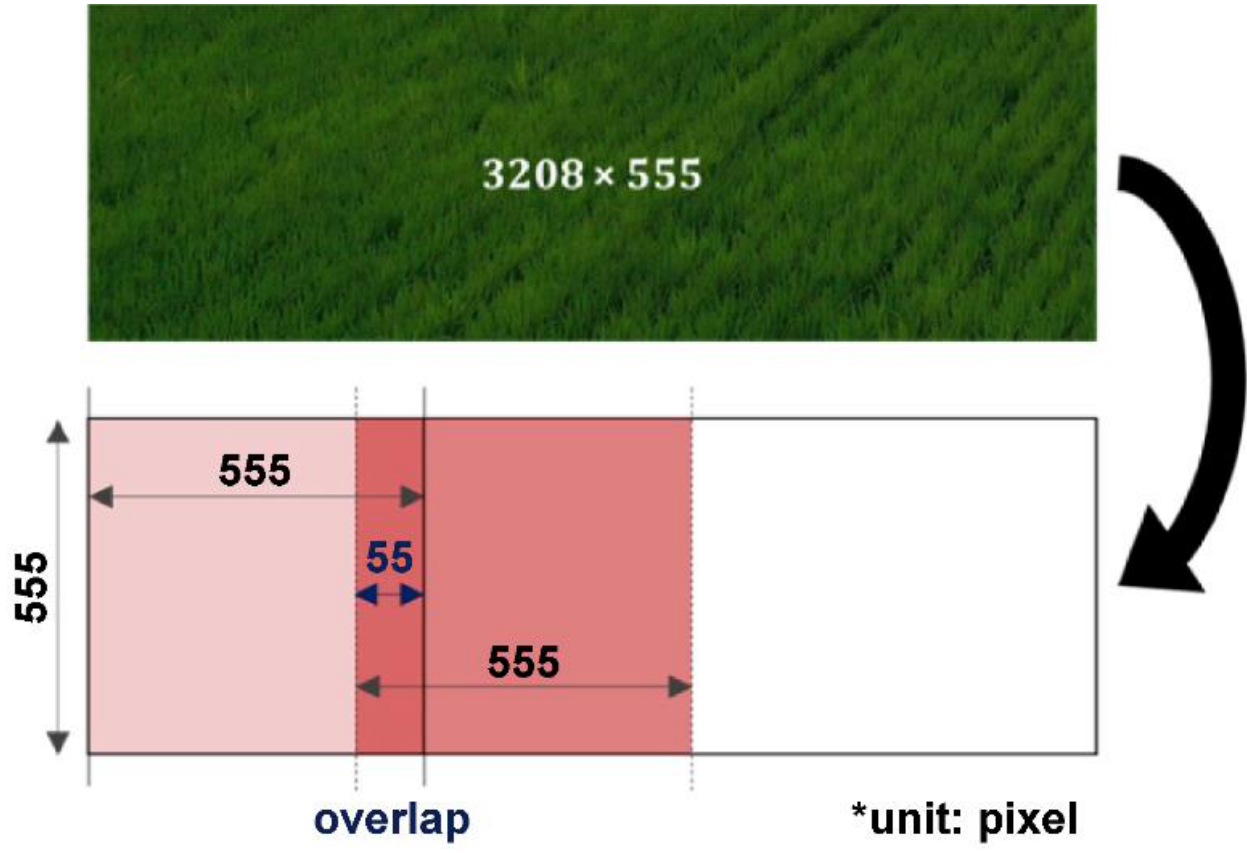
Figure 10. The method of creating patch image data using sliding window.